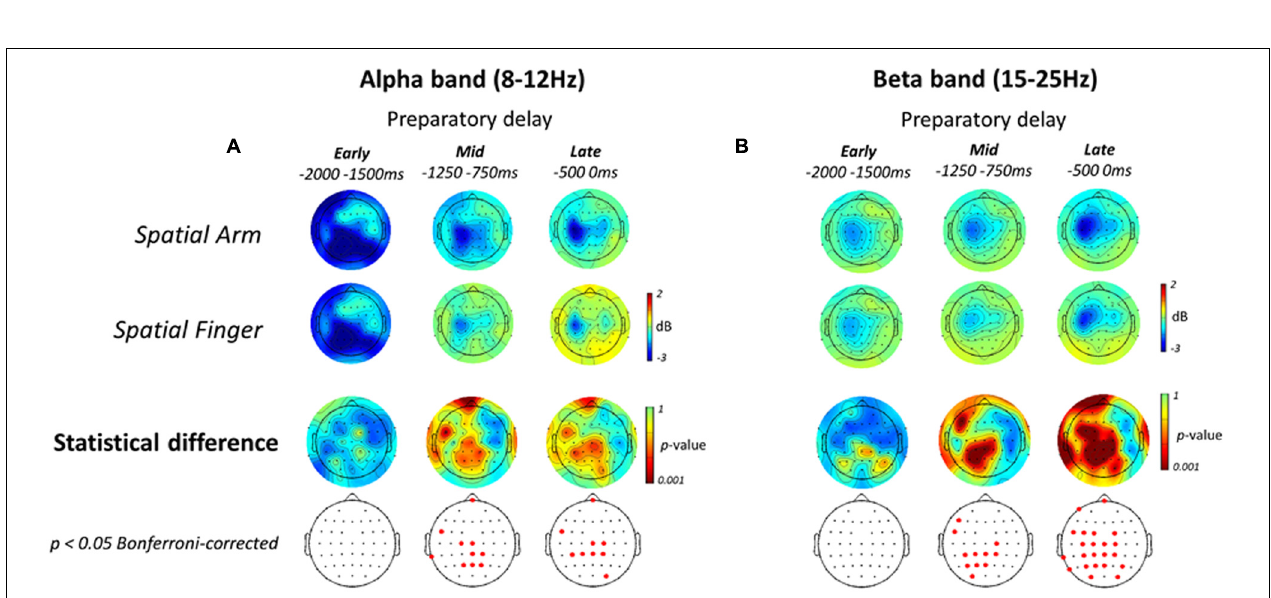
FIGURE 5 | Electroencephalography alpha- and beta-band ERD during Spatial reach planning. ( A , top two rows) Scalp topographic maps of alpha-band ERD in the Early, Mid, and Late planning epochs of the preparatory delay period, shown for the Spatial Arm and Spatial Finger conditions. ( A , bottom two rows) Scalp topographic maps of the statistical difference in alpha-band ERD between the Spatial Arm and Spatial Finger conditions, along with the electrodes that survive a p < 0.05 Bonferroni-corrected criterion. (B) Same as (A) but for beta-band ERD.